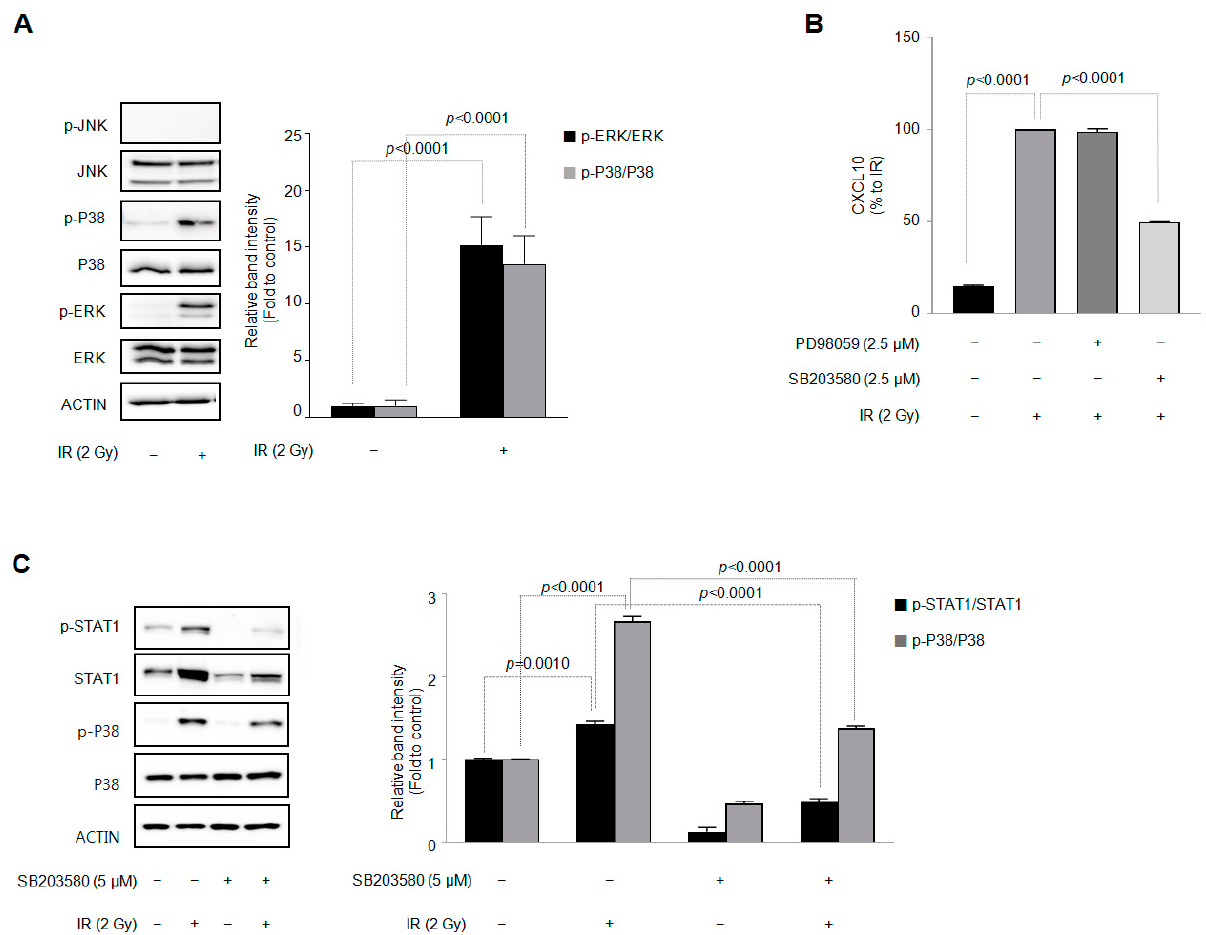
Figure 4. p38 MAPK activation by ionizing radiation is involved in the production of CXCL10 in J774A.1 macrophages. A total of 2 × 10 5 cells/mL of the J774A.1 macrophage cell line, with or without three MAPK subtype-specific inhibitors, namely, PD98059 (2.5 µ M) for ERK, SP600125 (2.5 µ M) for JNK, and SB203580 (2.5 µ M) for p38 MAPK, was exposed to 2 Gy of radiation. Forty-eight hours later, ( A ) the expression of the three MAPK subtypes and ( B ) the amount of CXCL10 released into